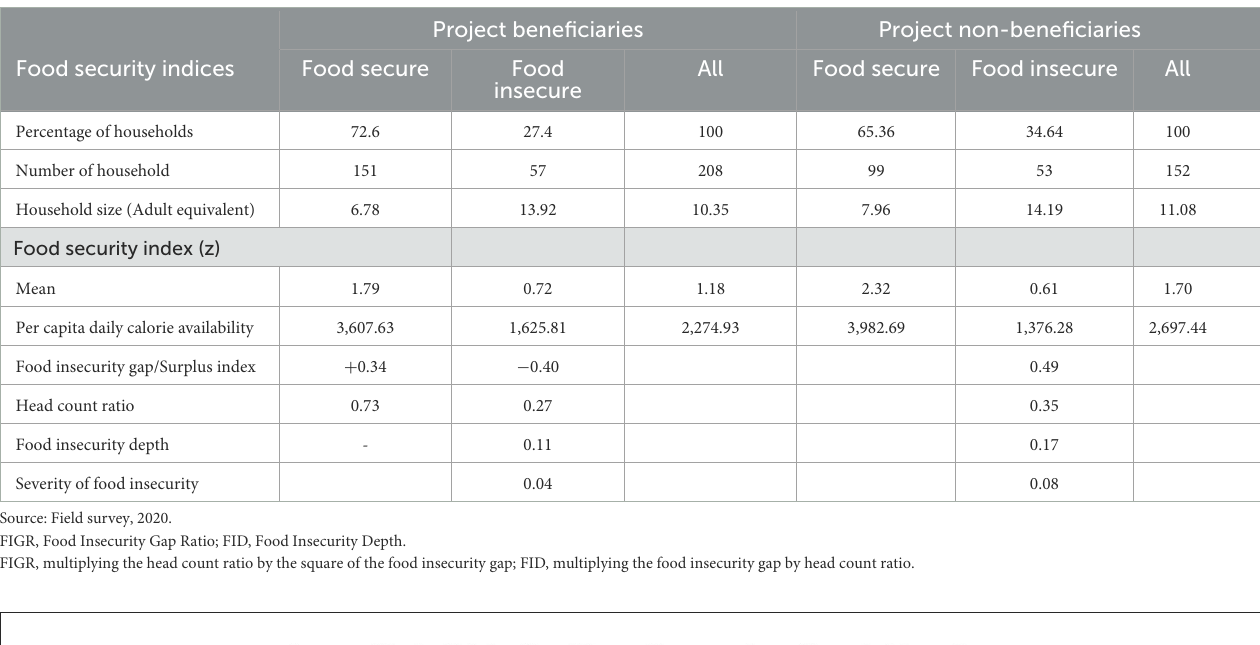
TABLE 2 Summary of the food security indices for project beneficiaries and